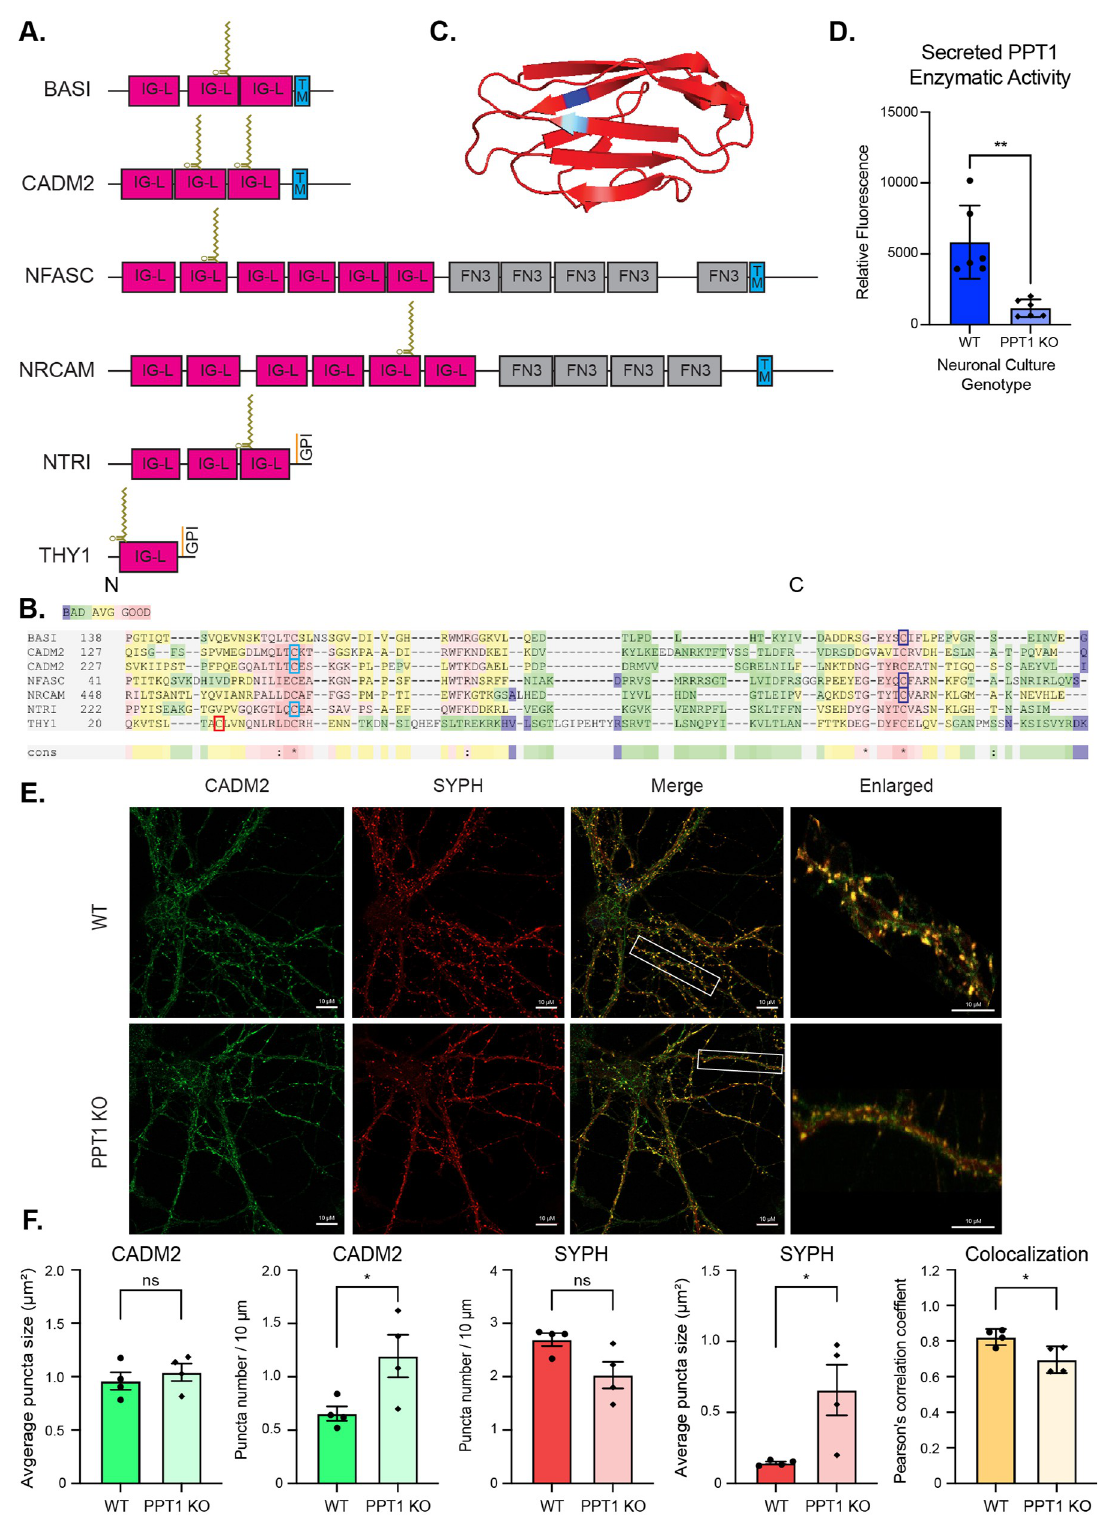
Fig 4. PPT1 depalmitoylates the IgG domain of synaptic adhesion molecules. 4. (A) Domain organization of IgG domain-containing synaptic adhesion molecules identified as high-confidence PPT1 substrates with palmitoylation sites represented as lipid chains. IG-L– Ig-like; FN3 –fibronectin 3; TM–transmembrane. (B) IgG domain-containing synaptic adhesion molecules show high